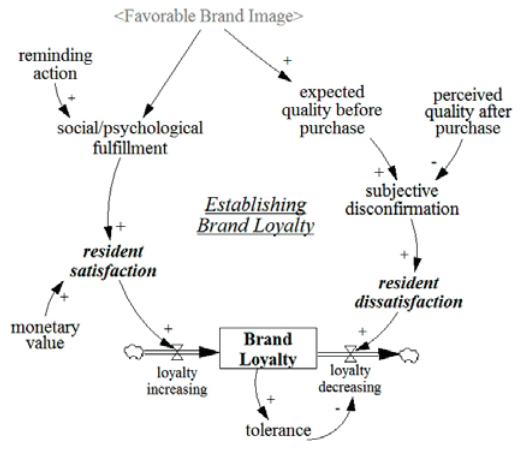
Fig. 4. Establishing brand